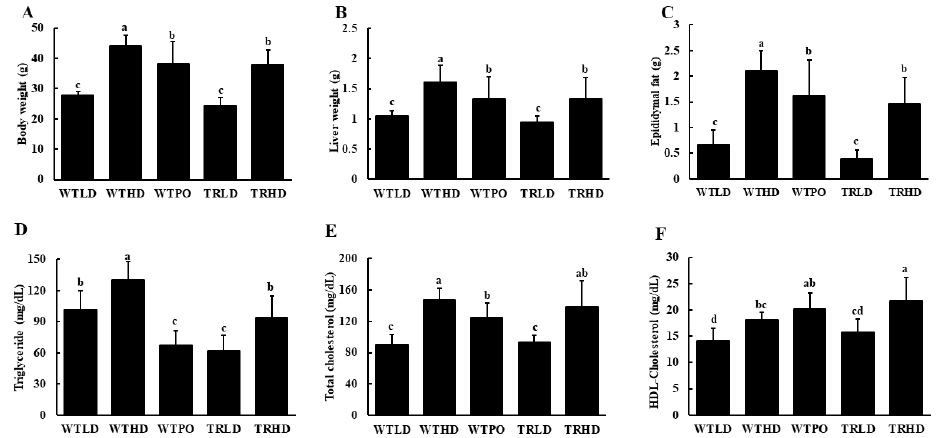
Figure 1. ( A ) Final body weight, ( B ) liver weight, ( C ) epididymal fat weight, ( D ) serum TG, ( E ) serum TC, and ( F ) HDL-C. Mice were divided into five groups ( n = 8); WTLD and TRLD fed a low-fat diet (LD, 10% kcal from fat); WTHD and TRHD fed a high-fat diet (HD, 60% kcal from fat); WTPO fed an HD + PO diet (60% kcal from fat diet, supplemented with 8% perilla oil in the diet). Values are expressed as mean ± SD, and those with different superscript (a, b, c) letters indicate significance between groups by ANOVA with Duncan’s test at p < 0.05.